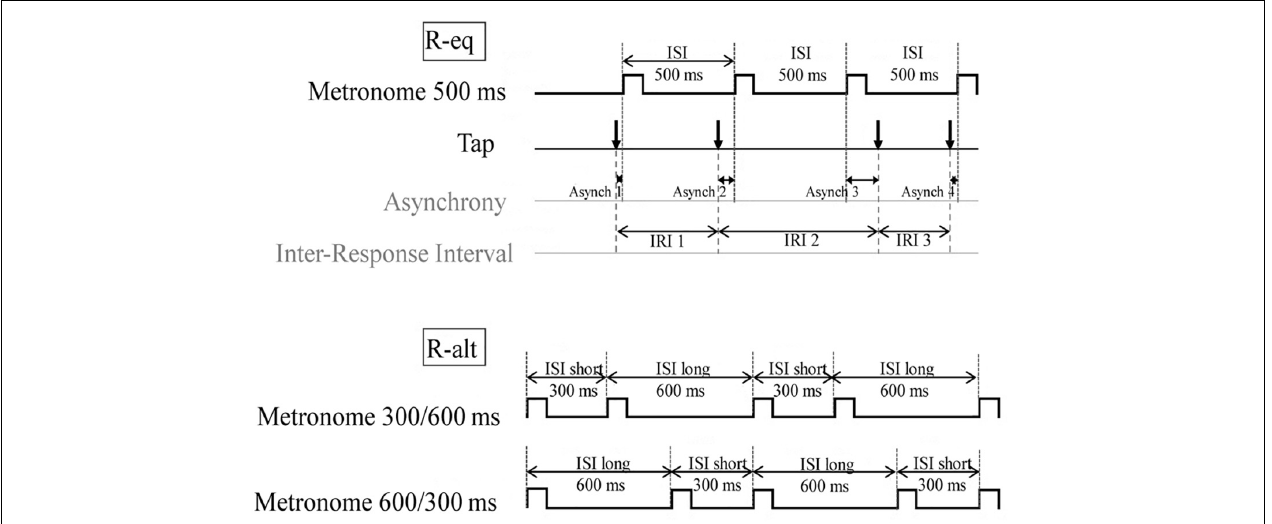
FIGURE 2 | Schematic illustration of the auditory sequences and measured variables (IRI and ASYNC), which were used as indicators of the performance levels observed in the sensorimotor synchronization task. Participants were instructed to synchronize their finger-tap following two different auditory sequences. Isochronous sequences were constituted of equivalent inter-stimulus intervals (ISIs) of time ( Top : R-eq; ISI = 500 ms). Non-isochronous sequences were composed of alternating time intervals ( Bottom : R-alt; ISI = 300/600 ms or ISI = 600/300 ms). This figure also specifies the indicators used to characterize the participants’ timing performances. The inter-response interval (IRI) refers to the time interval between the onsets of two successive taps produced by a participant (Top) and reflects the participants’ ability to produce accurately a timed motor sequence. The asynchrony indicator (ASYNC) was calculated as the time interval between the first detected point of contact between the finger and the screen (i.e., the tap action) and the start of the nearest tone. It is a marker of the participants’ ability to produce a motor response in synchrony with a predictable external event. By convention, signed asynchronies are negative when the tap is ahead of the target beep (e.g., ASYNC 1), and positive when the tap lags behind (e.g., ASYNC 3). ISI, inter-stimulus interval; IRI, inter-response interval; ASYNC, asynchrony (in